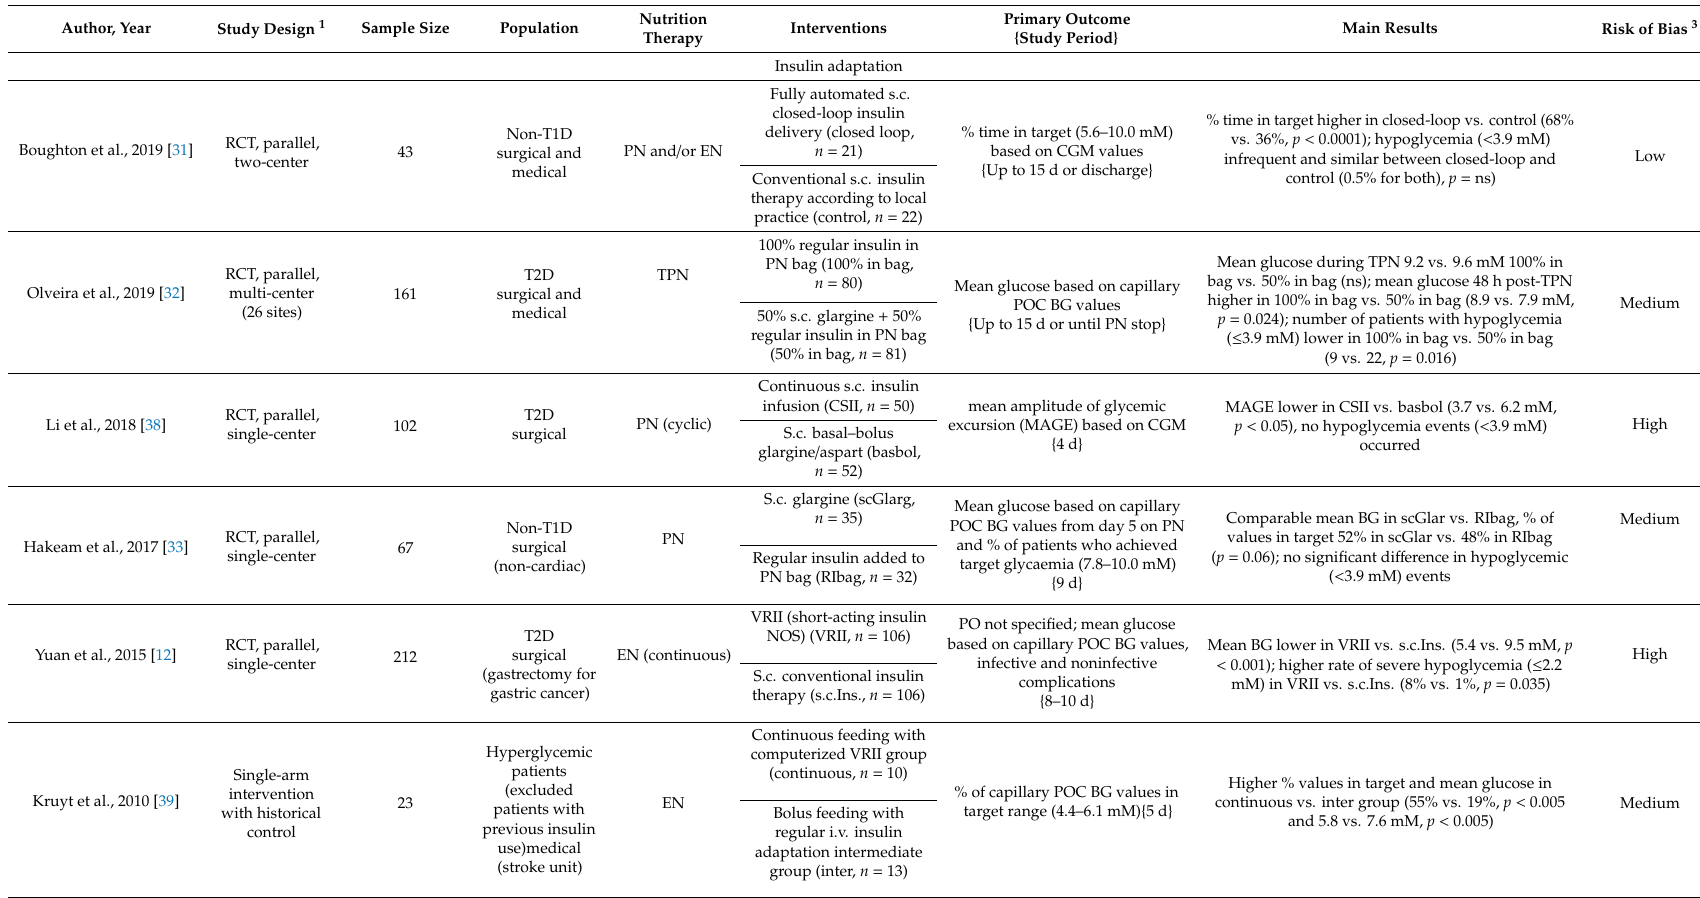
Table 1. Overview of clinical